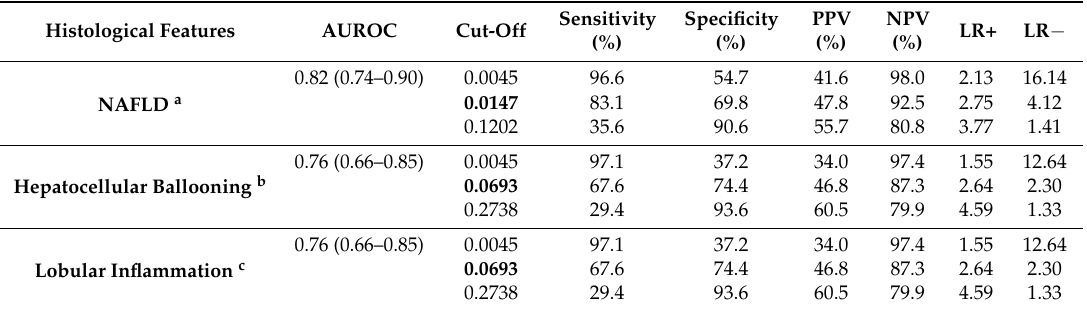
Table 2. Accuracy of the miR122 biomarker in the population